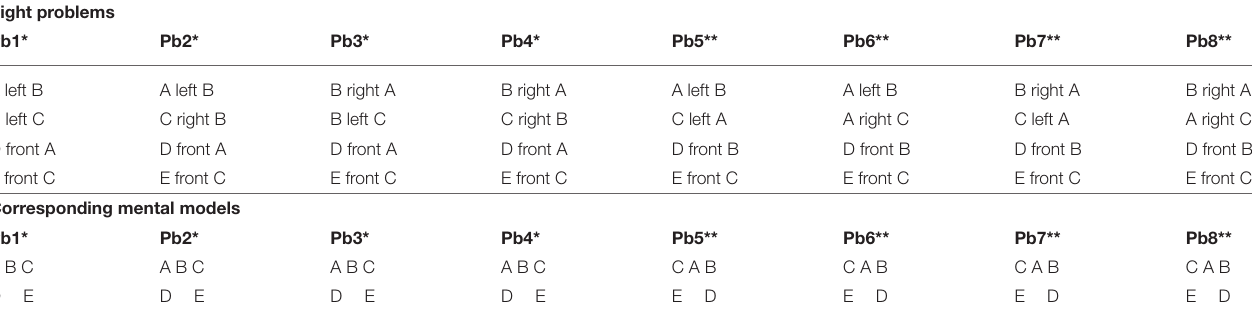
TABLE 1 | The eight problems used in Experiment 1 and their associated mental models (the question is: “What is the relation between D and E?”). Eight problems